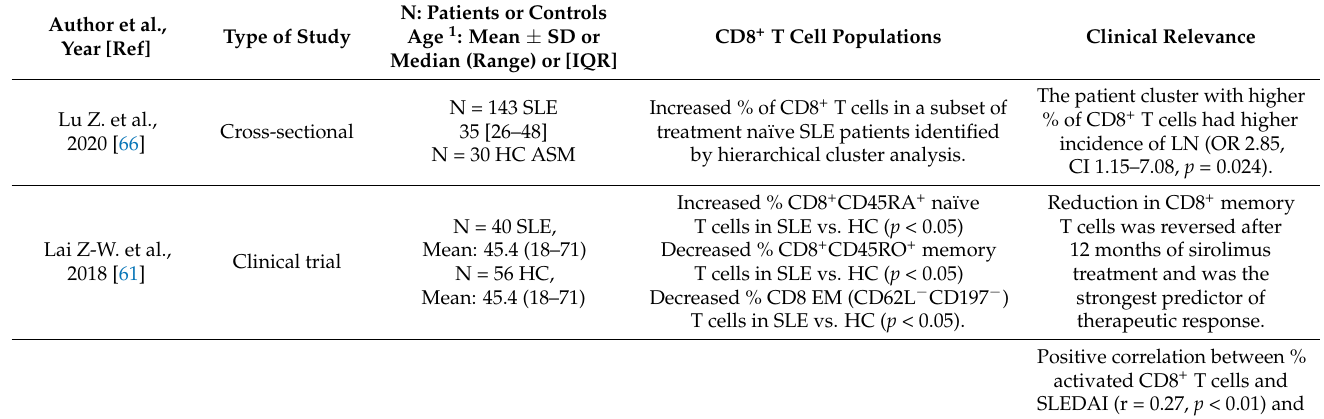
Table 2. Altered peripheral blood CD8 + T cell phenotype in adults with